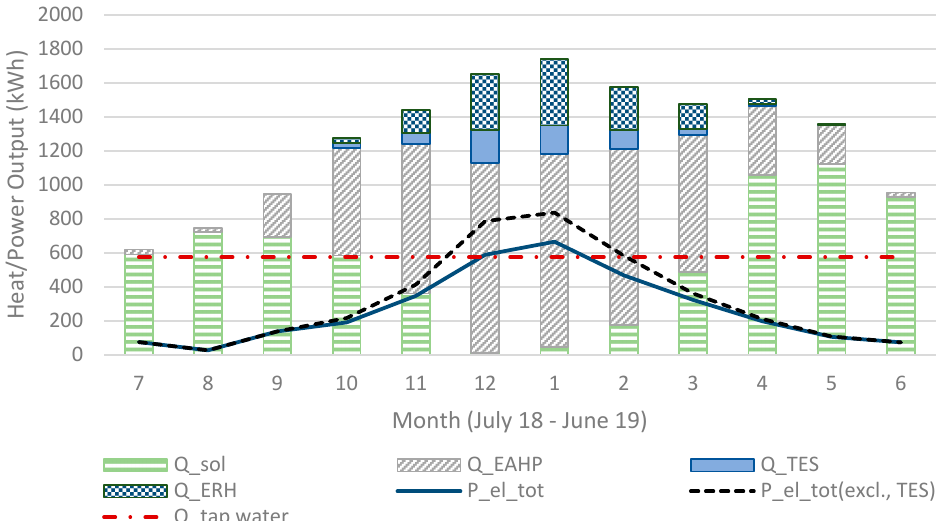
Figure 10. The sum of heat output (in Sim4) for all heat sources and electricity consumption for each month.